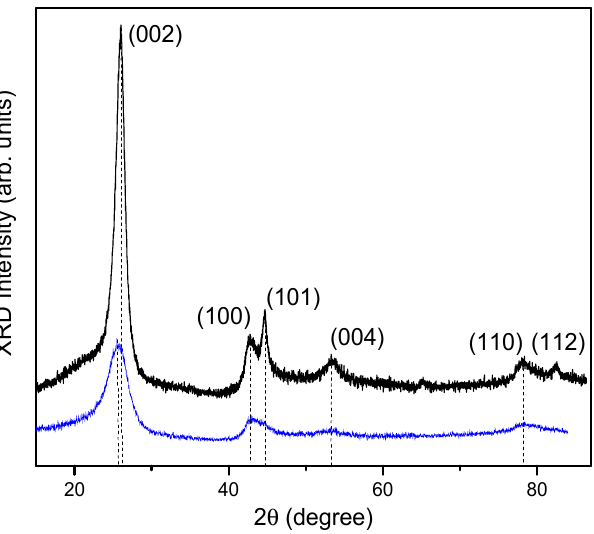
Figure 2. X-ray diffraction patterns for samples S1 (black curve) and S2 (blue curve). Maximum peaks in samples S1 and S2 are peaks (002). The asymmetry of these peaks indicates the presence of domains (different crystal structures) in MWCNTs [32]. Peaks